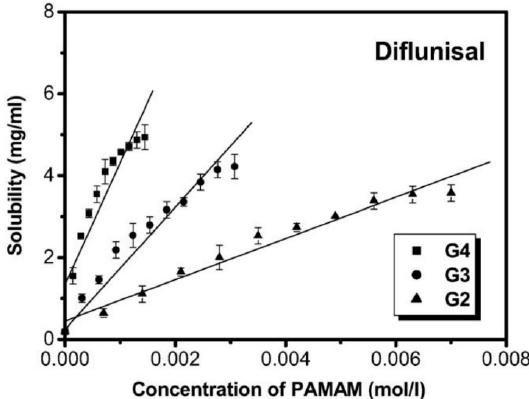
Figure 19. Solubility of diflunisal in the presence of dendrimers. Reproduced from [71], with permission from Elsevier, 2021.